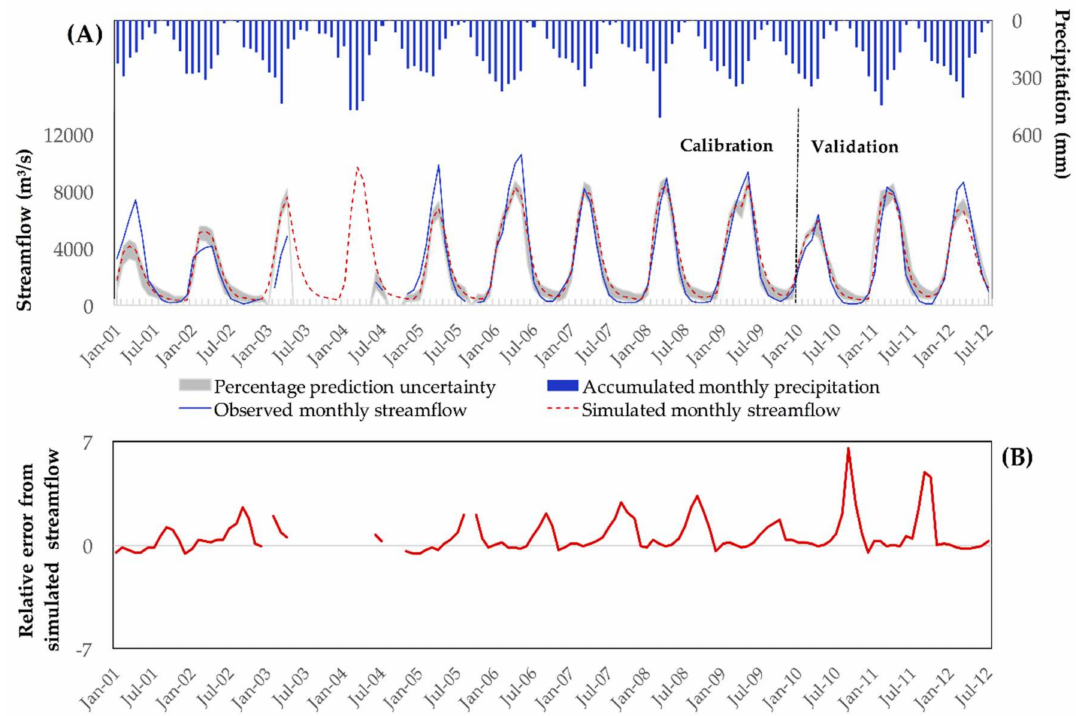
Figure 4. ( A ) Monthly simulated and observed streamflow, and the precipitation data used for the calibration and validation periods, and ( B ) relative error between monthly average streamflow (Relative error = (Q sim − Q obs )/Q obs ). Table 3. Coefficients used to assess the model performance during the calibration, validation and entire period, and the classification of model performance, according to Moriasi et al. [86]. Coefficient Calibration Period Validation